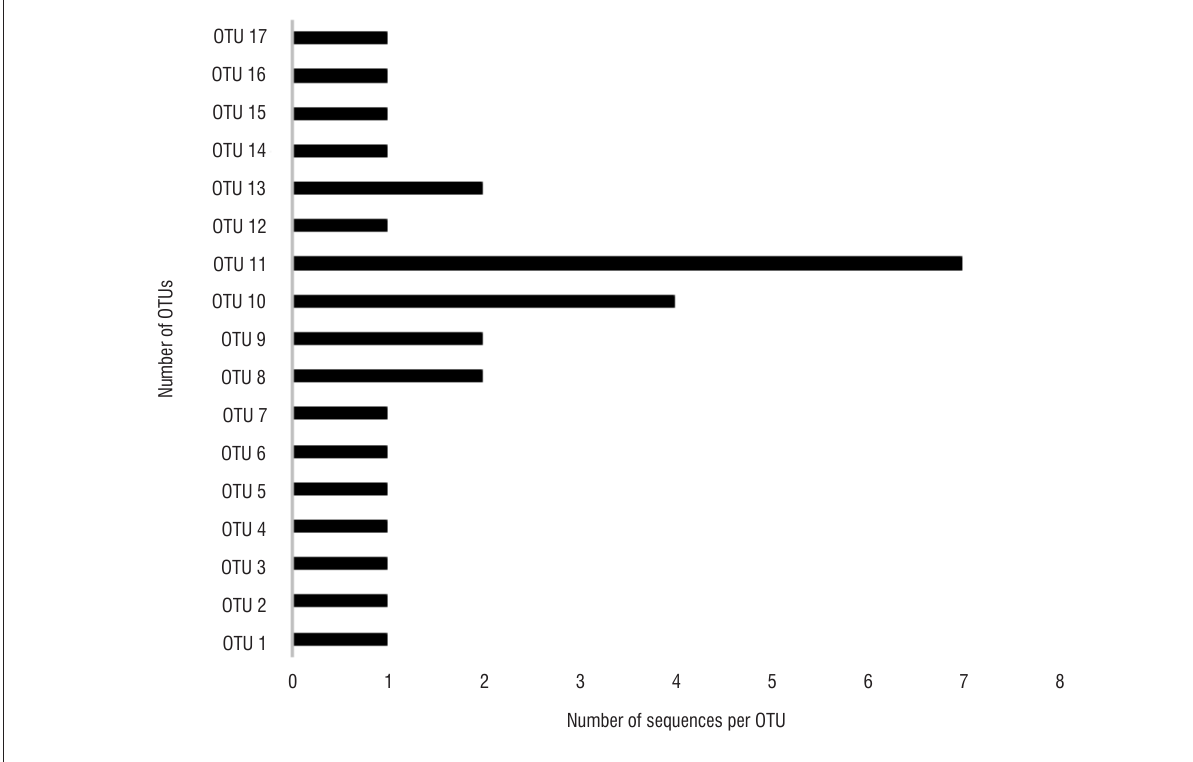
Figure 1: Operational taxonomic units (OTUs) of 16S bacterial sequences obtained from 50-day-old Bt and non-Bt maize plants.